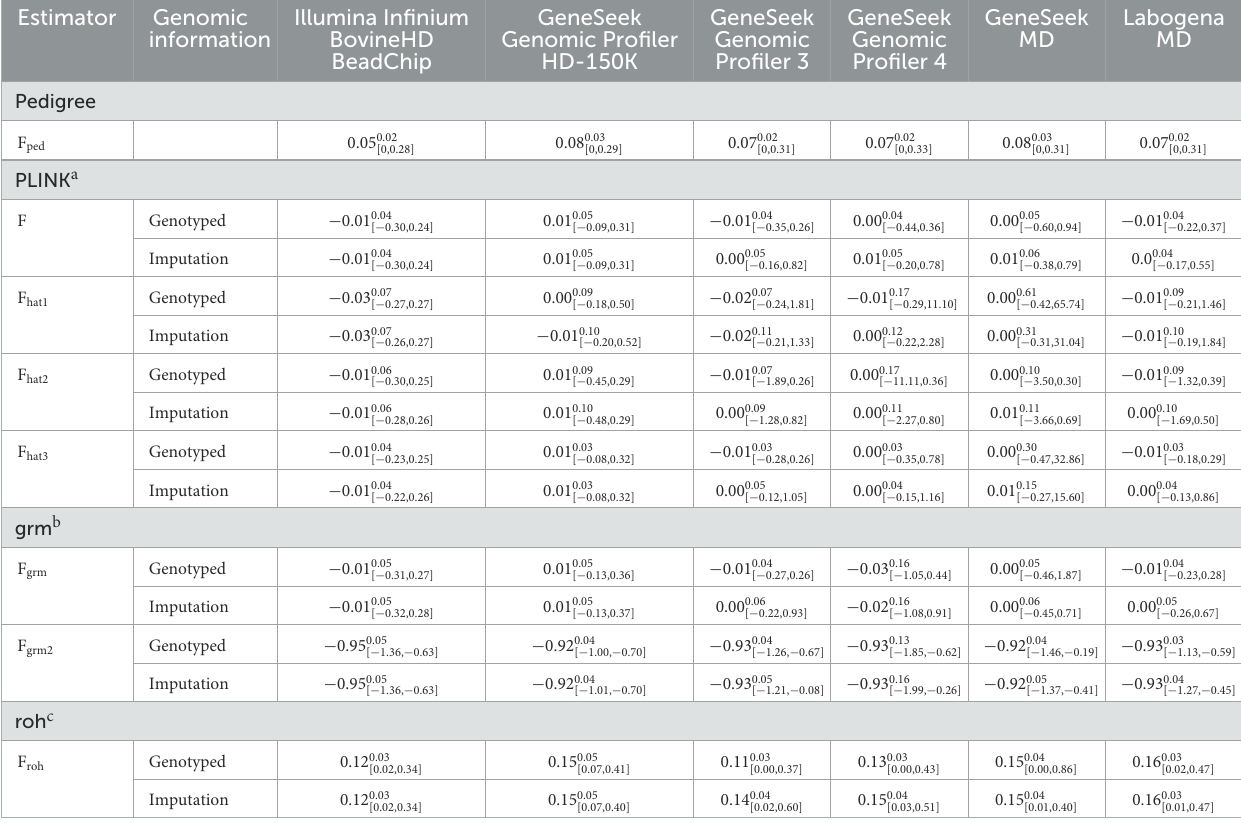
TABLE 2 Mean, standard deviation (superscript) and range (subscript) of the pedigree and the genomic inbreeding coefficients for each genotyping